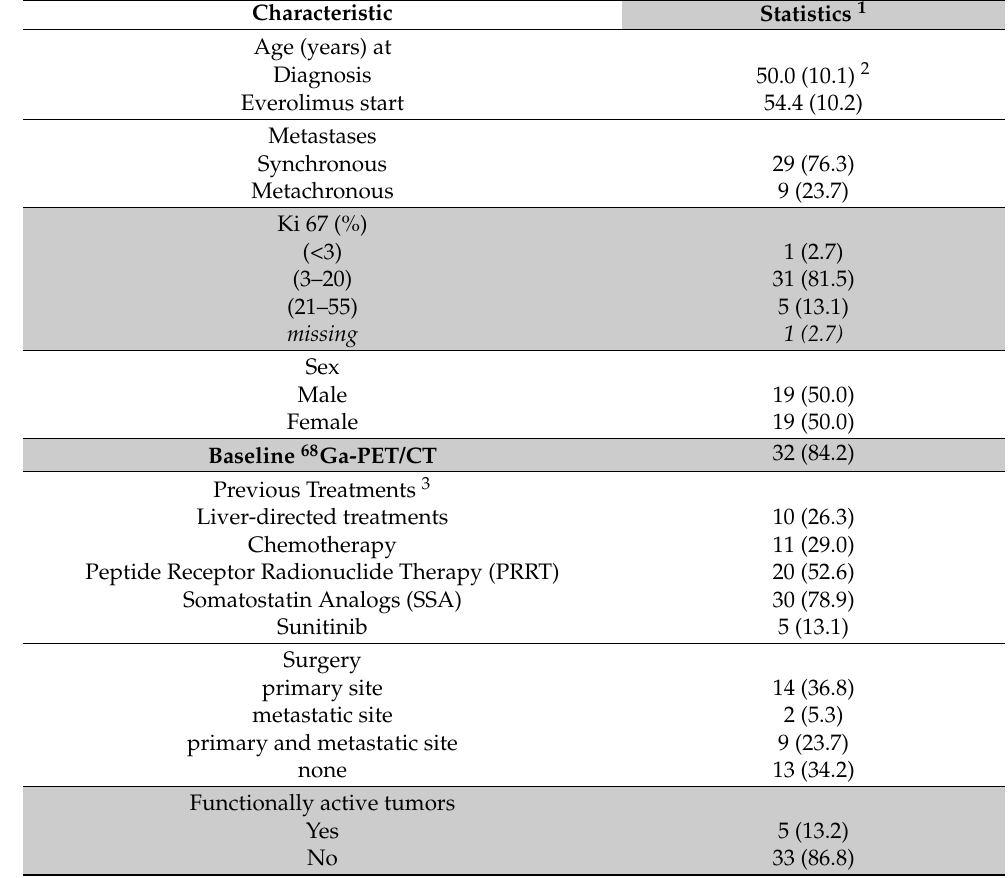
Table 1. Patient’s characteristics and clinical course, N =